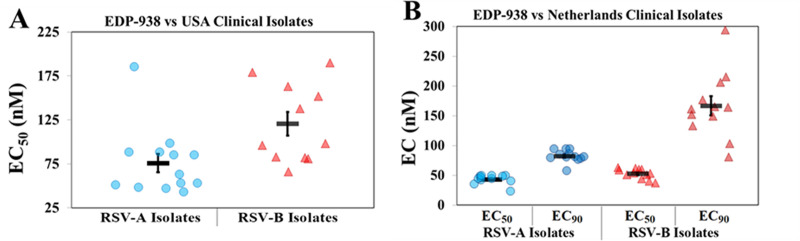
In vitro activity of EDP-938 against RSV clinical isolates.(A) Average EC50 of EDP-938 against RSV-A and RSV-B USA derived clinical isolates. (B) EC50 and EC90 (half maximal and 90% inhibitory concentration) of EDP-938 against 10 RSV-A and RSV-B clinical isolates from the Netherlands. Bold bars indicate the mean ± SEM.